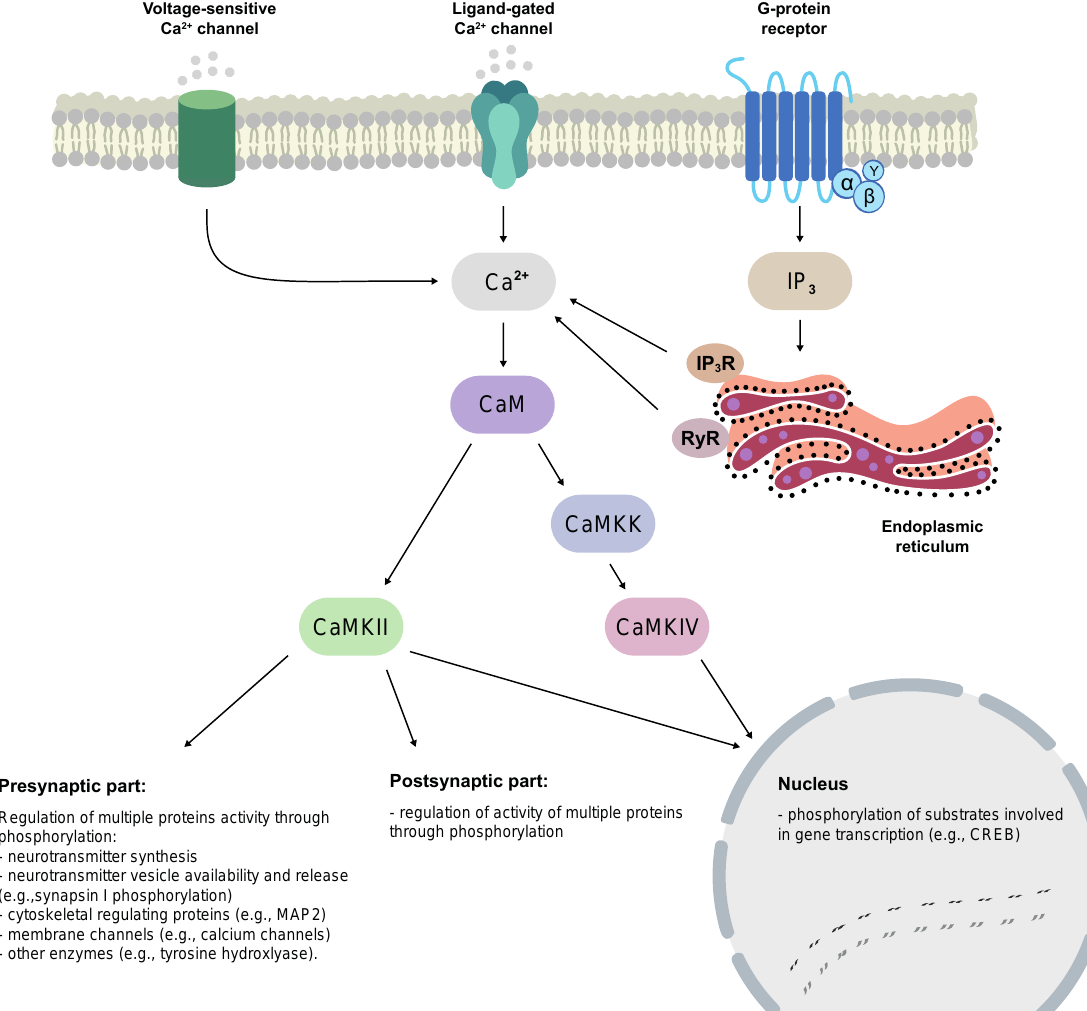
Figure 1. The calcium/calmodulin-dependent kinase (CaMK) II and CaMKIV activation cascades and function in the central nervous system (based on [2–4]). Cytoplasmic Ca 2+ concentrations rise in response to either the activation of voltage-sensitive Ca 2+ -channels, ligand-gated ionotropic channels, or G-protein-coupled receptors in the plasma membrane or by its release from endoplasmic reticulum via IP 3 R or RyR. Next, CaM binds Ca 2+ ions and either activates CaMKII directly or activates CaMKK, which in turn phosphorylates CaMKIV. CaM—calmodulin, CaMKK—CaMK kinase, CREB—cAMP response element-binding protein, IP 3 —inositol trisphosphate, IP 3 R—IP 3 receptor, MAP2—microtubule-associated protein 2, RyR—ryanodine receptors.